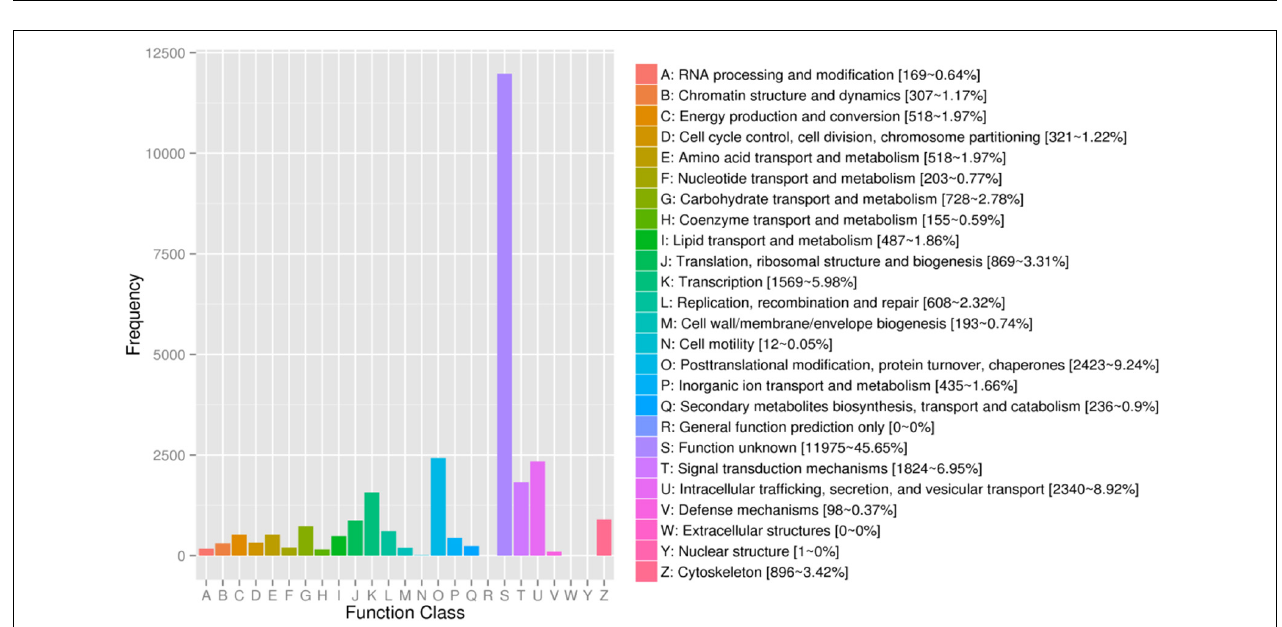
FIGURE 3 | The eggNOG functional classification of assembled unigenes. X -axis: the function class of eggNOG, Y -axis: the frequency of unigens.